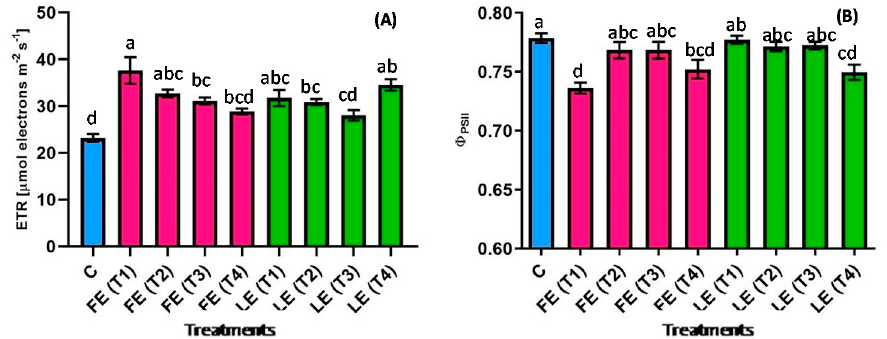
Figure 4. The electron transport rate (ETR) ( A ) and the effective quantum yield of photosystem II in the light ( Φ PSII ) ( B ) in rocket leaves treated with water (control = C) and with borage extracts (flowers extract = FE or leaves extract = LE) obtained with different maceration times: 1 day (T1), 3 days (T2), 7 days (T3), and 14 days (T4). Values are means ± SE ( n = 5). Data were subjected to one-way ANOVA. Different letters, where present, represent significant differences among